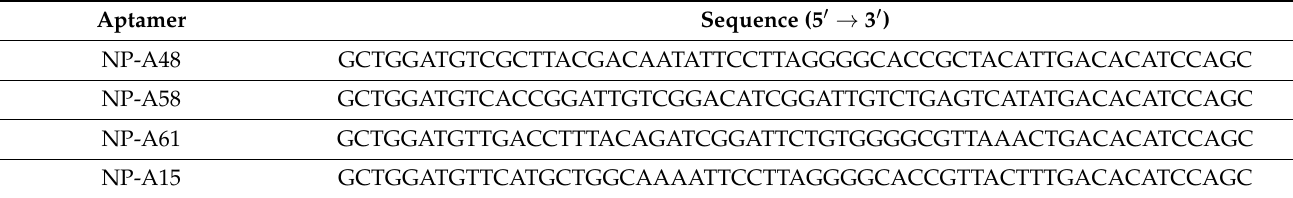
Table 1. The sequence of the ssDNA aptamers for the SARS-CoV-2 N-protein